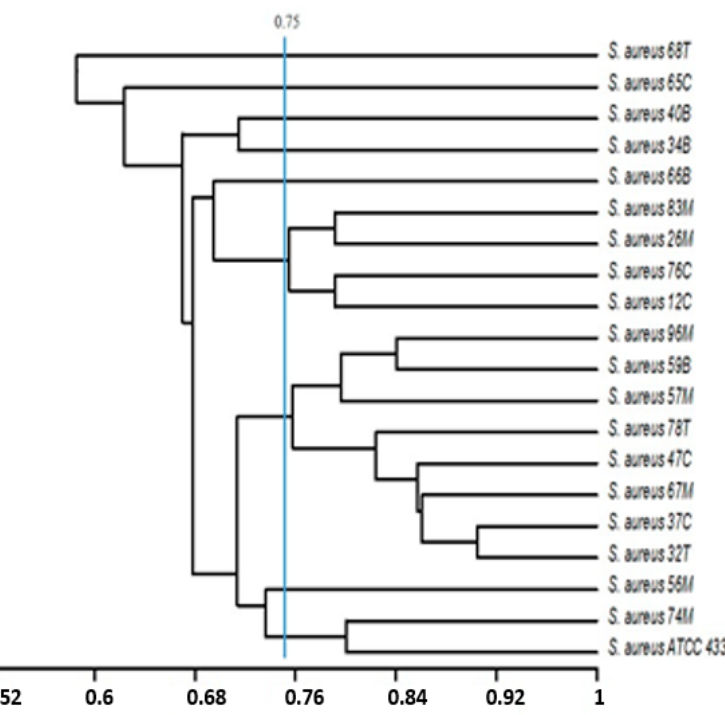
Figure 3. Dendrogram based on the unweighted pair group method of arithmetic averages and Jaccard’s correlation coefficient on the basis of the phenotypic characters of the S. aureus population (exoenzymes produced, susceptibility to antibiotics, and biofilm formation capacity). Numbers on the horizontal axis indicate the percentage of similarity.